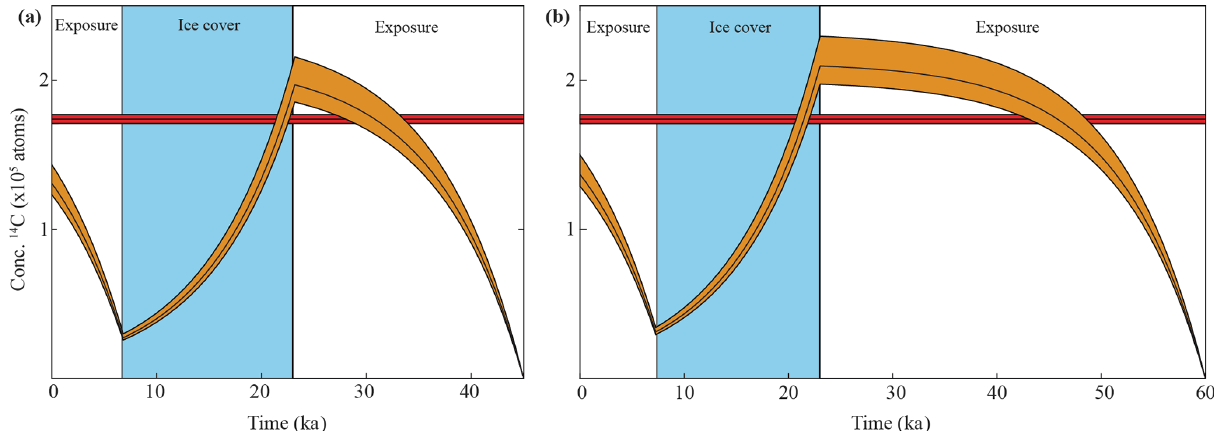
Figure 5. Modelled exposure scenario for boulder sample GL1701. The red line shows the measured in situ 14 C concentration in the sample and the orange line is the nuclide concentration build-up and decay during periods of exposure and ice cover. Panel (a) shows exposure from 45 to 23ka and again from 6.7ka until present and ice cover in between. Panel (b) shows exposure from 60 to 23ka and again from 6.7ka until present and ice cover in between.